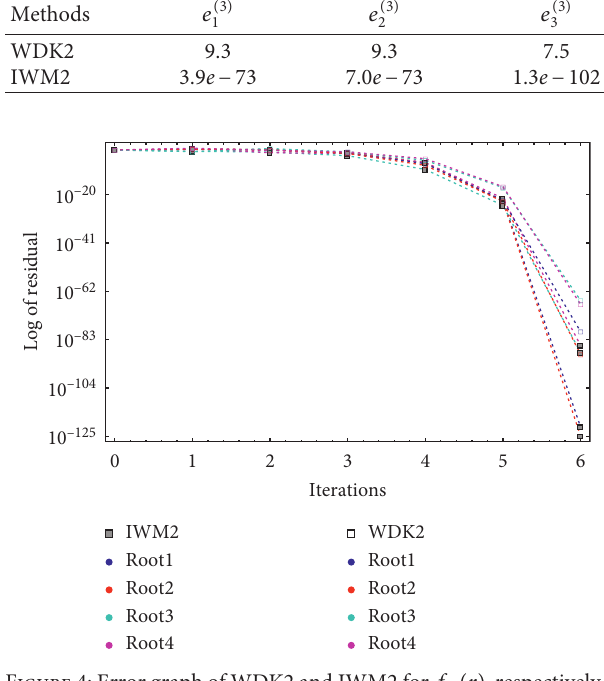
( r ) , respectively. 3